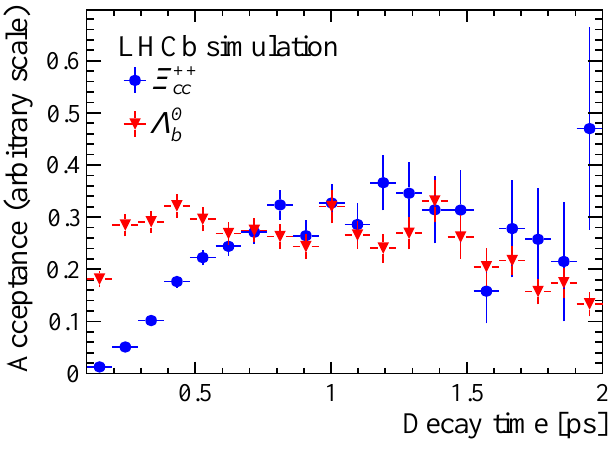
Figure 4. Decay time acceptances of the Ξ ++ match the transverse momentum distribution seen in